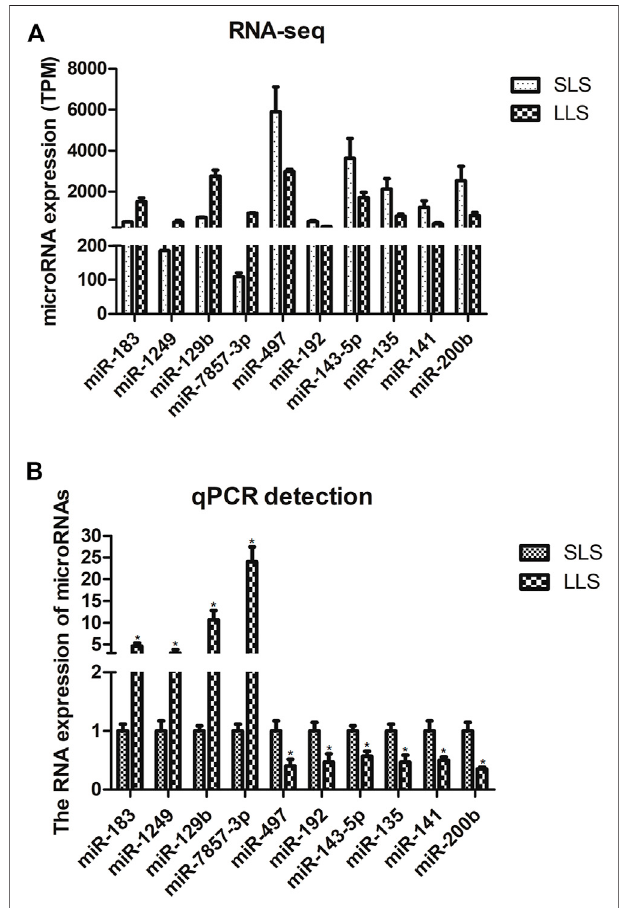
FIGURE 3 | Validation of candidate differentially expressed microRNAs by quantitative PCR (*, p < 0.05; n (cid:1)